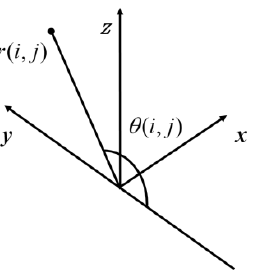
Figure 2. The coordinate system in which the LIDAR data are collected.